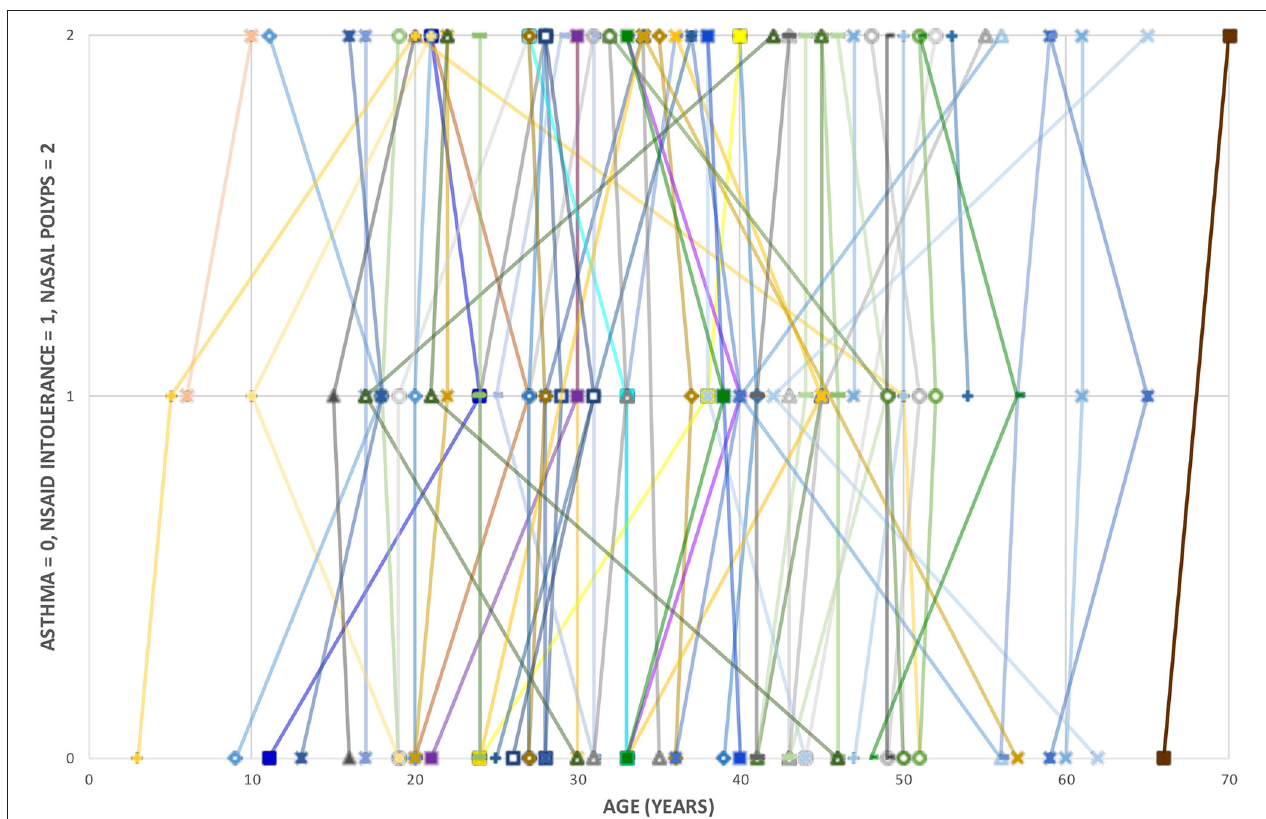
FIGURE 2 | Disease-specific contraction age of 66 included